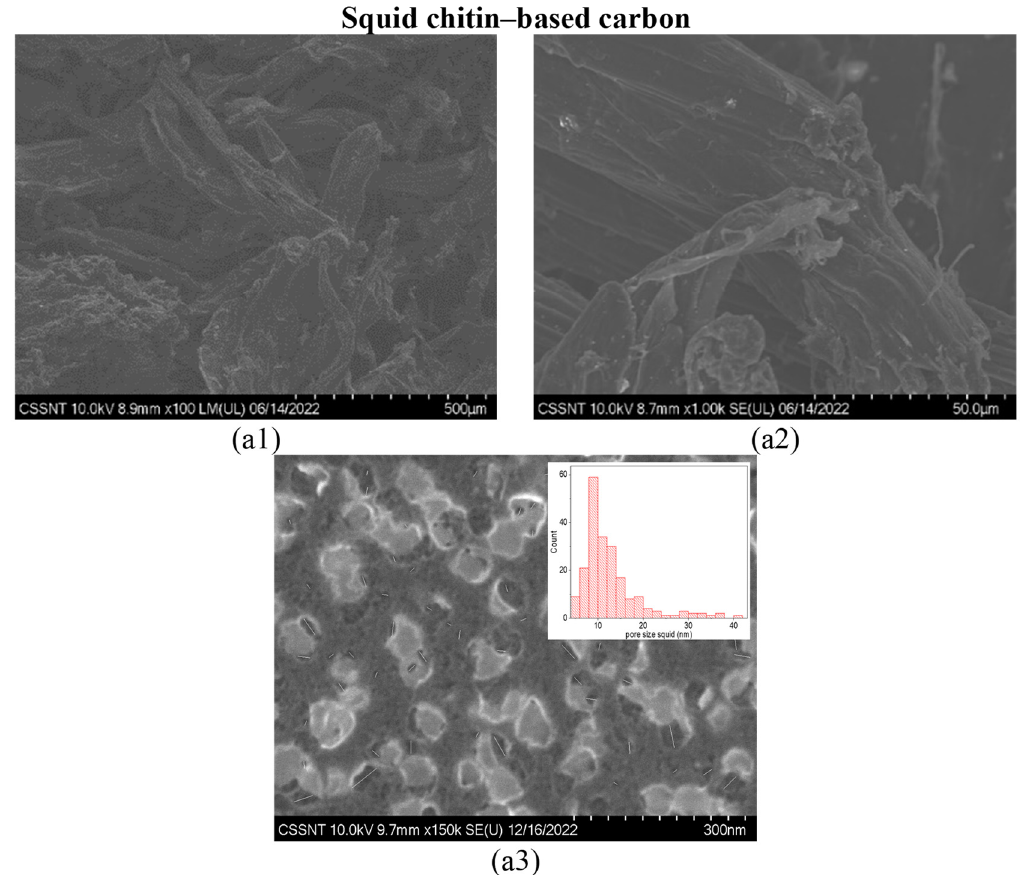
Figure 1. SEM images of squid chitin-based carbon (carbonized at 1000 °C for 1 h) at different magnifications: ×100 ( a1 ), ×1 k ( a2 ), and ×150 k ( a3 ) with the pore size distribution in the inset of ( a3 ).